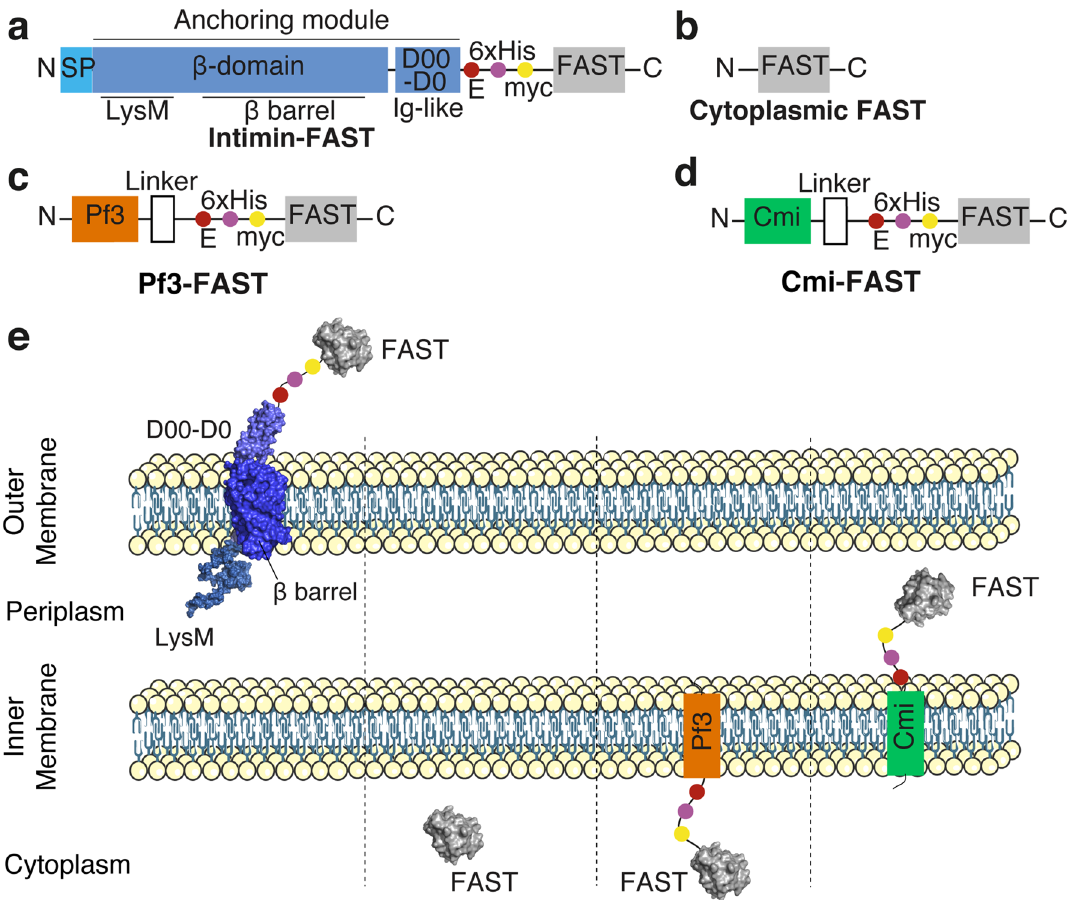
Figure 1. Schematic representation of the different FAST constructs used for E. coli in this study. FAST was fused to different scaffolds to allow its presentation as an E. coli cell-surface protein through the anchoring domain of the intimin ( a , e ), a free cytoplasmic protein ( b , e ), an inner-membrane attached cytoplasmic protein through the use of Pf3 transmembrane domain ( c , e ) or an inner-membrane attached periplasmic protein through the use of Cmi transmembrane domain ( d , e ). FAST structure was modeled using Phyre2 22 based on the structure of the Photoactive Yellow Protein (PYP, PDB d1nwza) it derived from. The structure of the anchoring module of intimin corresponds to original structures of respectively, the intimin LysM domain (PDB 2mpw), the intimin ß-barrel domain (PDB 4e1s) and the D00-D0 Ig-like domain (PDB d1f00i1 and